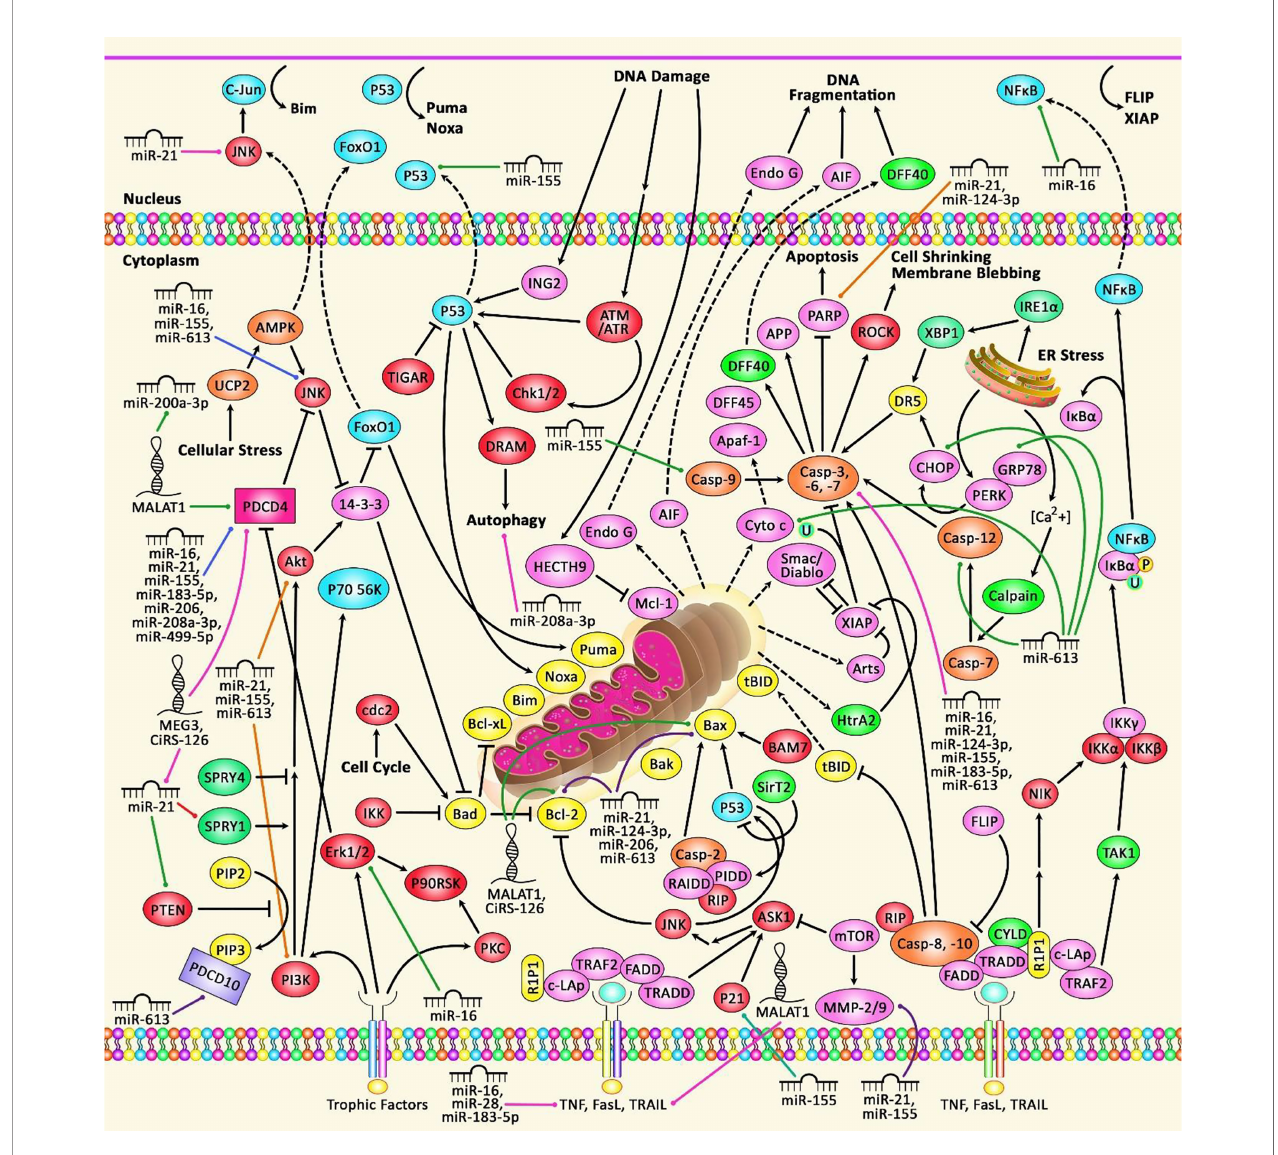
FIGURE 2 | A schematic diagram of the functional interactions between PDCDs proteins and various ncRNAs in non-neoplastic disorders. Apoptosis, a gene-controlled process of programmed cell death (PCD), is a cascade which is induced in normal cells under physiological conditions and pathological stress. Dysregulation of apoptosis can result in uncontrolled cell proliferation that can play a signi fi cant role in causing various non-neoplastic disorders including heart diseases, polycystic ovary syndrome, and several immune disorders. The death receptors include Fas receptors, TNF receptors, and TRAIL receptors. As a surface receptor, TNF-R1 can interact with TNF to induce the recruitment of adaptor proteins FADD and TRADD, which can recruit a series of downstream factors, such as Caspase-8, that is a key modulator of the extrinsic cascade, eventually leading to cell apoptosis. In the intrinsic cascade, the functional outcome of the pro-apoptotic pathway is mitochondrial membrane perturbation and release of cytochrome c in the cytoplasm, where it can create a complex with APAF1 and the inactive form of caspase-9. In order to trigger the activation of caspase-9, this complex hydrolyzes adenosine triphosphate. Consequently, the initiator caspase-9 can cleave and upregulate the executioner caspases-3/6/7, leading to cell apoptosis (42, 43). Growing evidence suggests that dysregulation of PDCDs is associated with several non-neoplastic disorders and importantly their interaction with different ncRNAs (miRNAs and lncRNAs) is also